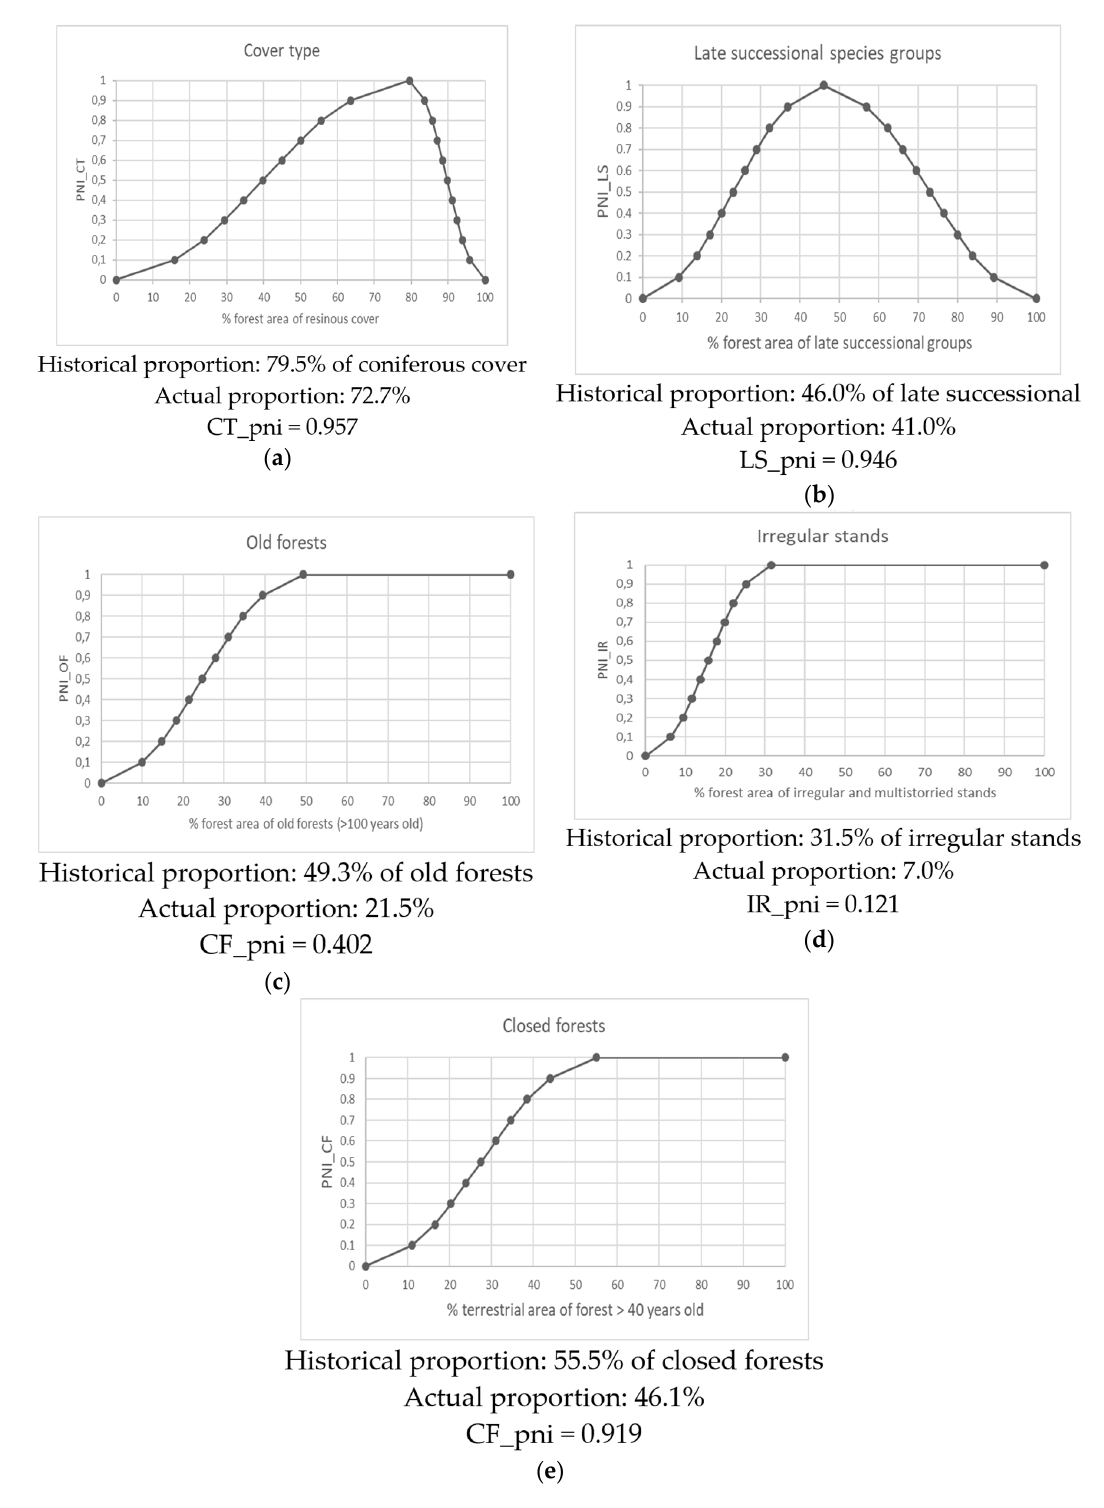
Figure 5. Pni determination curves used for condition indicators’ evaluation for three forest management units (3FMU) in the boreal black spruce-feathermoss bioclimatic domain: ( a ) Coniferous cover type; ( b ) late successional species groups; ( c ) old forests; ( d ) irregular stands; ( e ) closed forests.